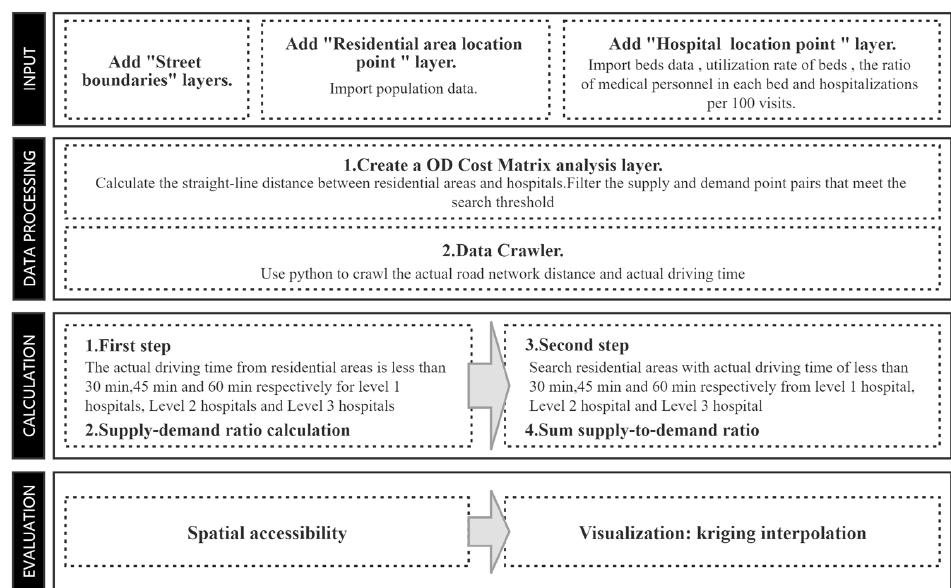
Figure 7. Implementation of the 2SFCA model in the Geographic Information System (GIS).